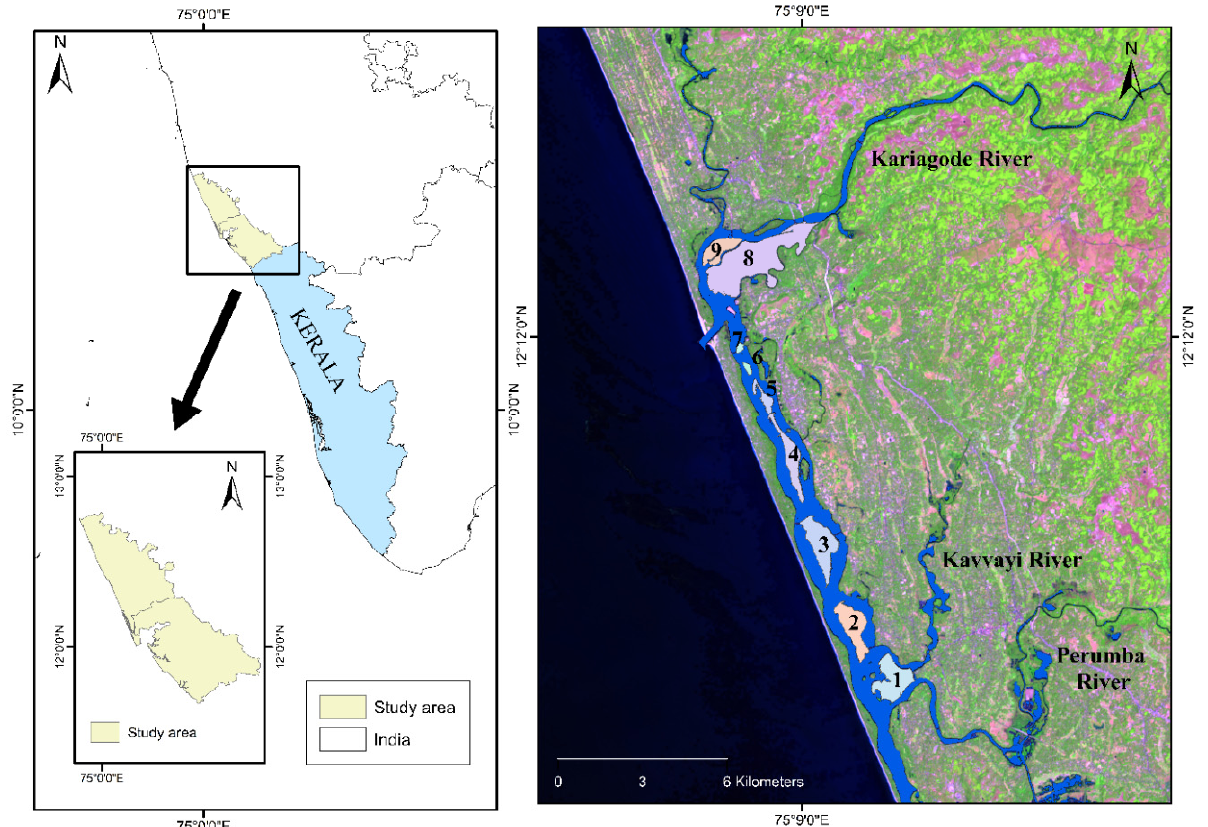
Figure 1. Map showing the study area with nine major islands. 1—Kavvayi, 2—Madkel, 3—Yedalekad, 4—Tekkekad, 5—Badkekad, 6—Kotekurup, 7—Chamandemad, 8—Achanturthi, and 9—Purtemad.